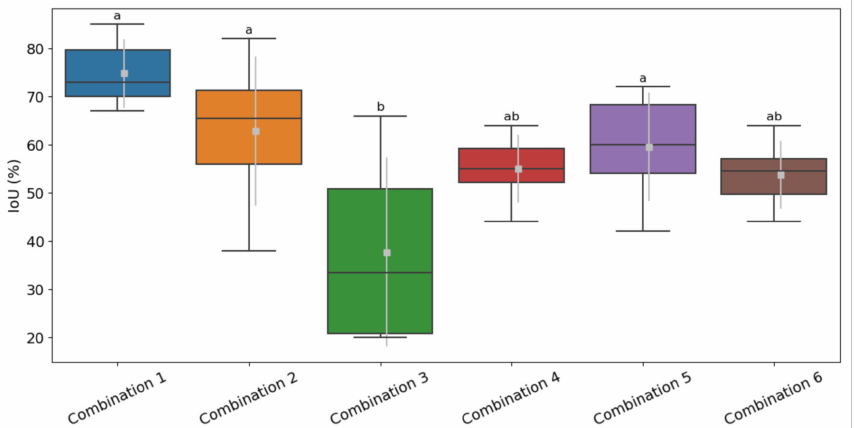
Figure 5. IoU results of six parameters and input combinations (detailed in Table 1) applied to the mean shift segmentation algorithm. The box represents 50% of the data, from the 25th percentile to the 75th percentile. The horizontal line inside the box represents the median of the data. The lines extending from the box (whiskers) represent the lower or upper quartiles. The gray lines represent the standard deviation, and the gray squares represent the average of each combination.